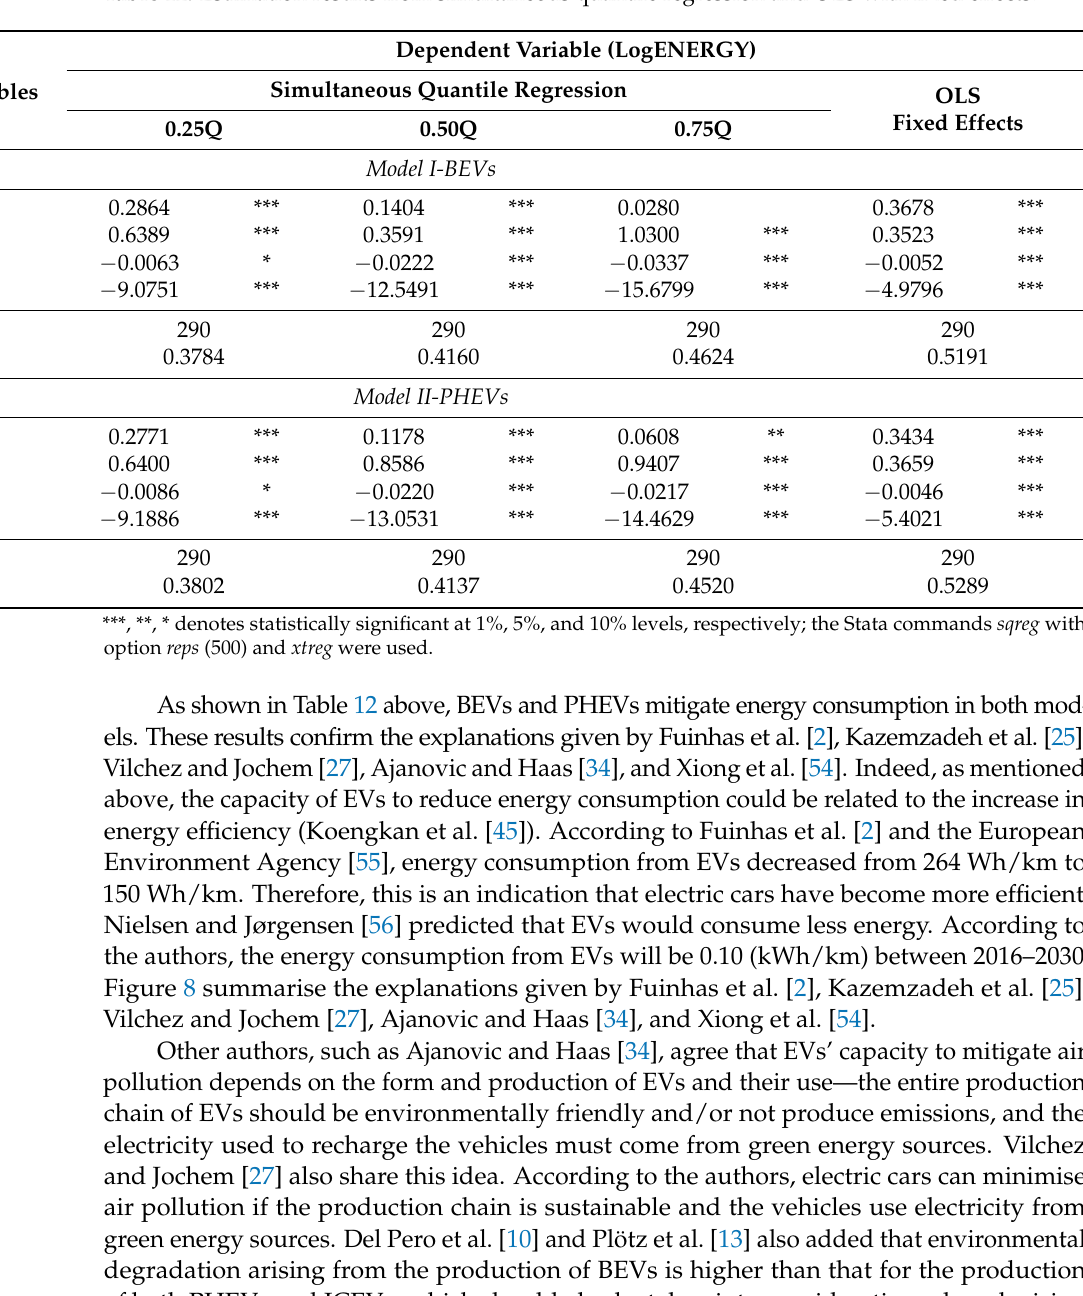
Table 12. Estimation results from simultaneous quantile regression and OLS with fixed